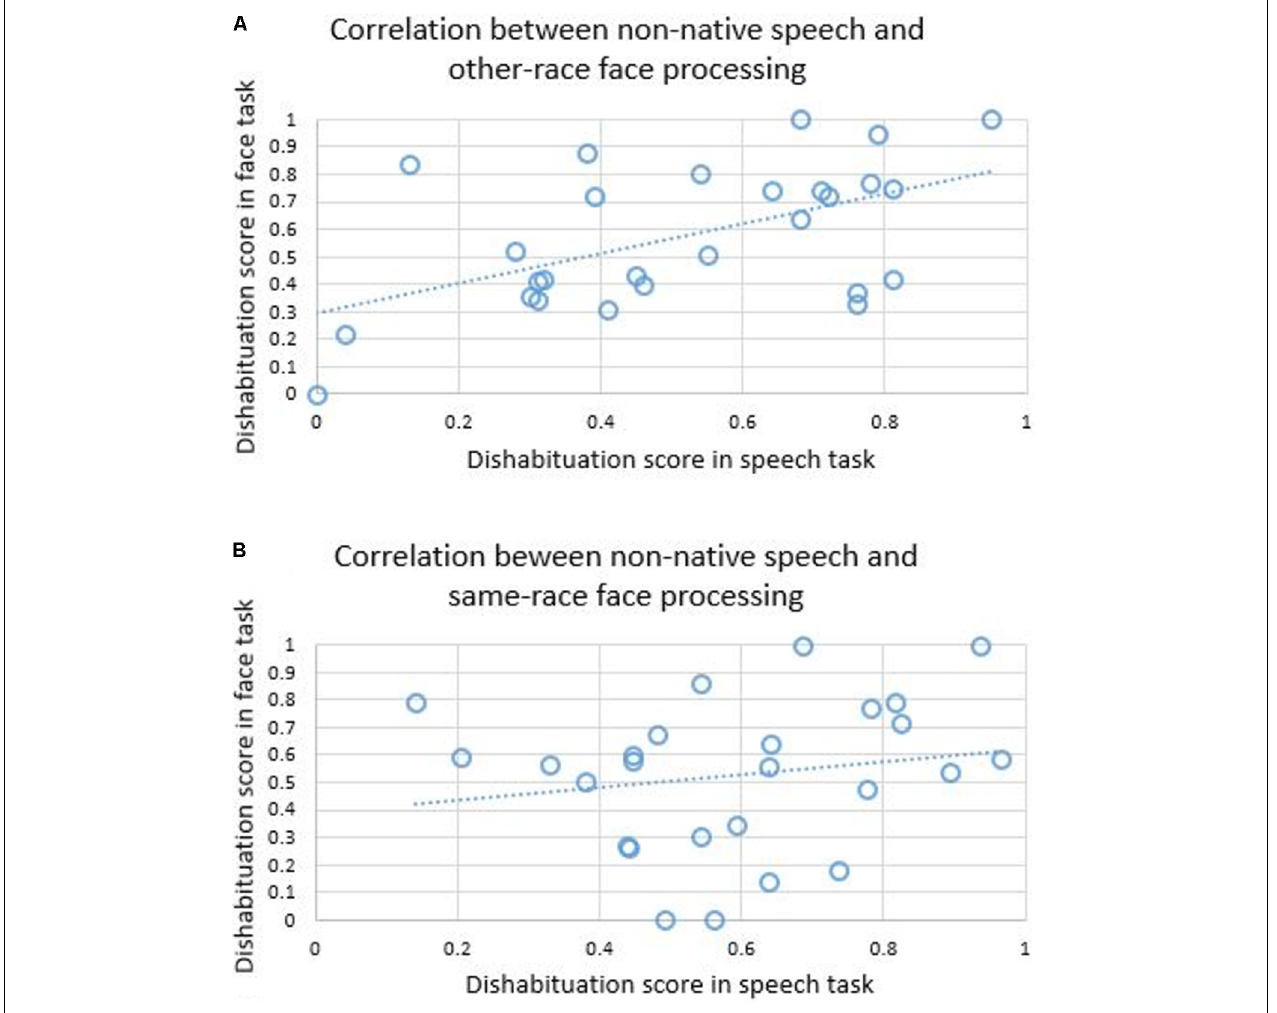
FIGURE 2 | Correlations between dishabituation scores in the non-native speech and other-race face task (A) , and between dishabituation scores in the non-native speech and same-race face task (B)